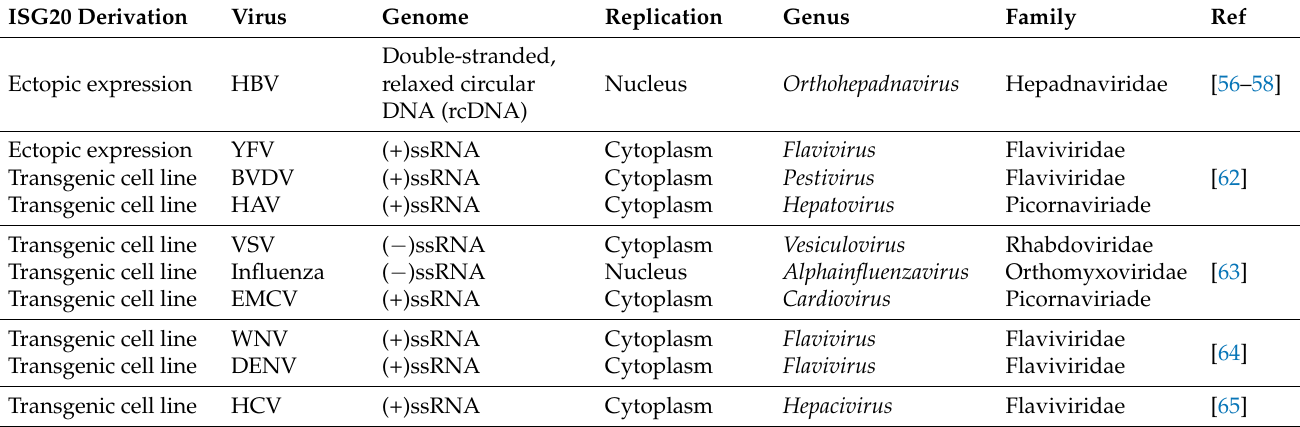
Table 2. ISG20 exhibited an antiviral effect against viruses via viral genome